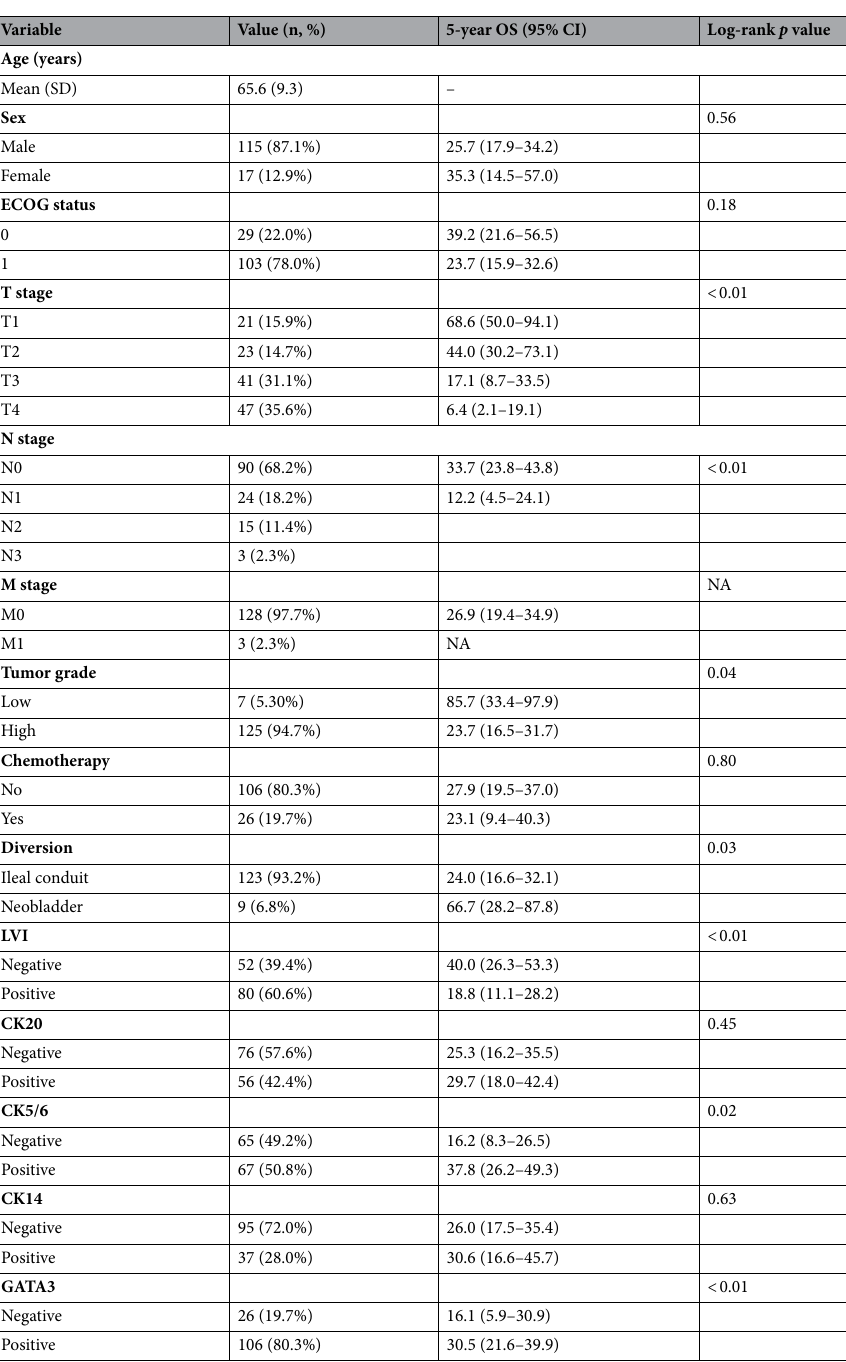
Table 1. Clinicopathological features of the 132 patients who underwent radical